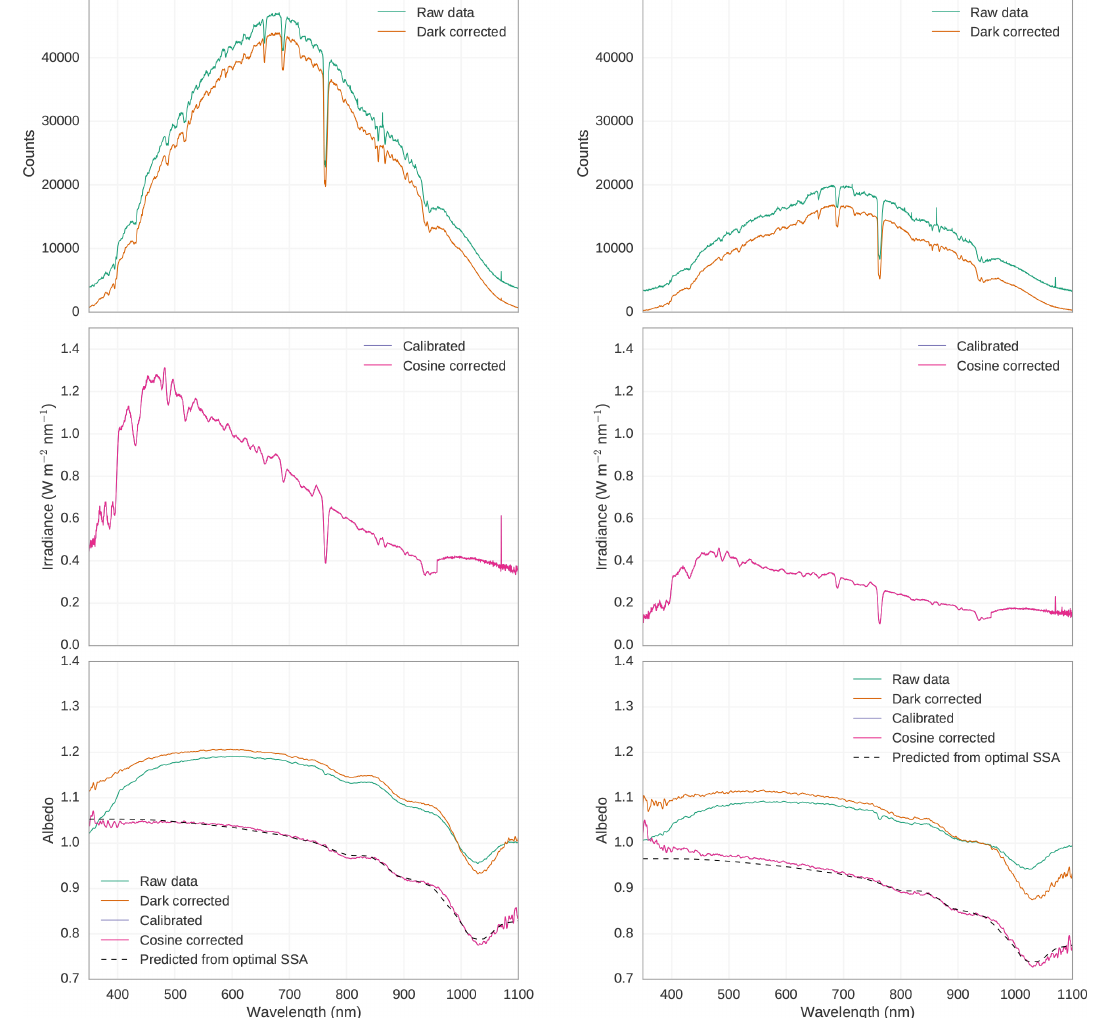
Figure 10. Incident spectrum and albedo at different stages of the processing for 10 January 2013 (left) at 12:12LT and (right) at 20:12LT. Raw data (green) are first corrected for the dark current and stray light (orange) then calibrated (violet) and last corrected for imperfect collectors (pink). The theoretical spectrum that fits the fully corrected spectrum (pink) is shown in